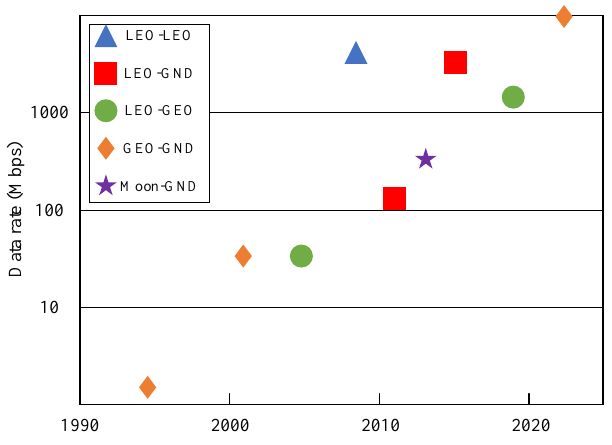
Figure 1. Nodes [8–18] of deep-space optical communication